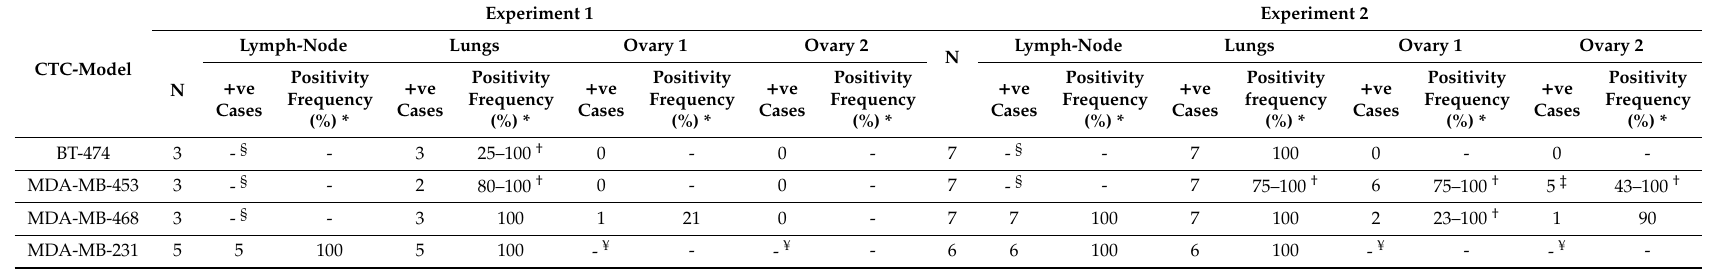
Table 2. The metastasis sites and frequencies in breast cancer xenograft